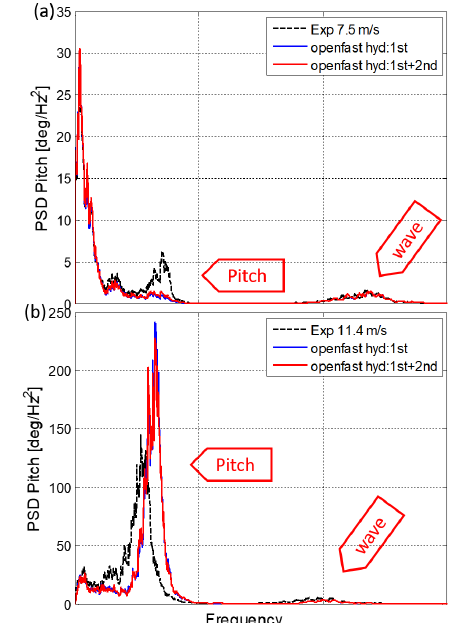
Figure 12. Pitch PSD response of SATH 10MW under turbulent wind with average of (a) 7.5ms − 1 and irregular waves with H s = 2 . 0m and T p = 8 . 5s and (b) 11.4ms − 1 and irregular waves with H s = 3 . 0m and T p = 10 .